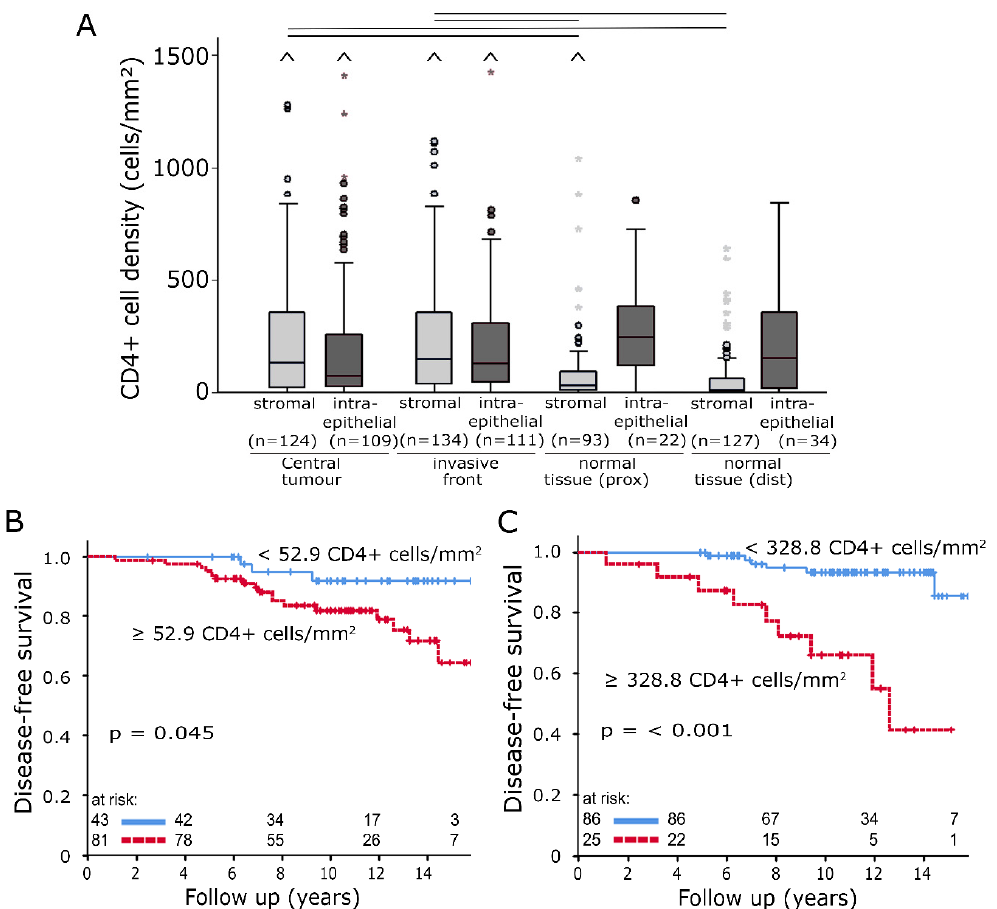
Figure 4. ( A ) Stromal and intraepithelial cell density distributions of CD4 + tumour-infiltrating inflammatory cells (TIICs) in samples from four di ff erent locations. The central line represents median values, while the box is indicative of the interquartile range (IQR). Whiskers represent 1.5 × IQR or minimum / maximum. Outliers are indicated by points (up to 3 × IQR) or asterisks ( > 3 IQR). Outliers not visible in this diagram are depicted as a caret. Black bars signify p < 0.05 in Student’s t test. ( B , C ) Disease-free survival analysed with the Kaplan–Meier method and log-rank test according to CD4 + TIIC densities in the intraepithelial compartment of invasive front samples ( B ) and in the stromal compartment of central tumour samples ( C ). Table 2. Correlations between stromal CD4 + and CD20 + TIICs in di ff erent locations. CD20 + TIIC Densities CD20 + TIIC Normal Tissue